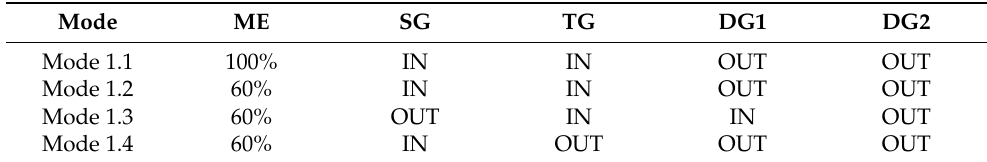
Table 1. 5MC90 2 engine room and modes of